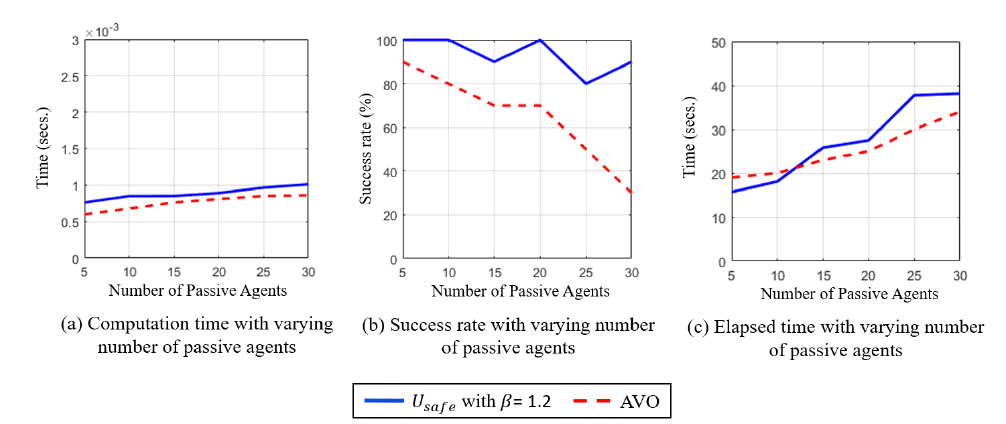
Figure 11. It shows the performance of AVO algorithm and the proposed U safe approach. The effect on average computation time, success rate, and elapsed time, are shown against varying number of passive agents. AVO: Acceleration-Velocity Obstacle.